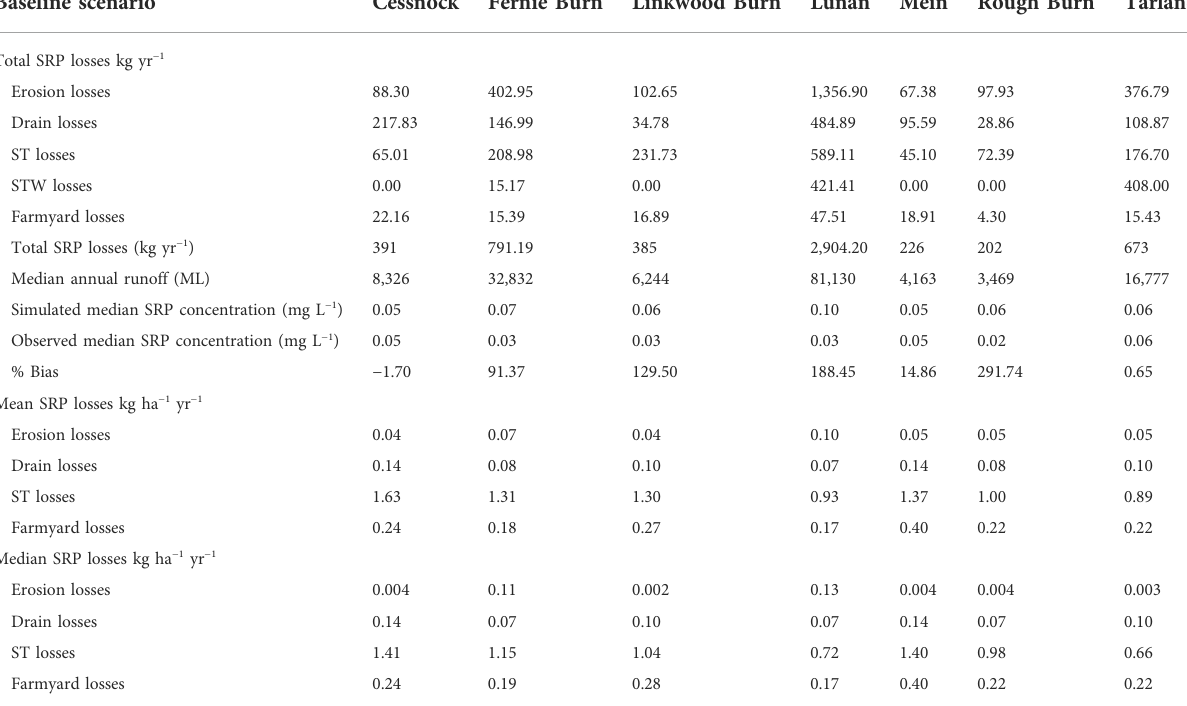
TABLE 2 Total annual SRP losses kg yr − 1 and mean SRP losses kg ha − 1 yr − 1 simulated using the discretised spatial implementation of the model and derived estimated SRP concentrations in the seven study catchments. Mean drain, ST and farmyard losses are calculated per area of catchment covered by these source areas. Mean erosion losses are calculated for the whole catchment